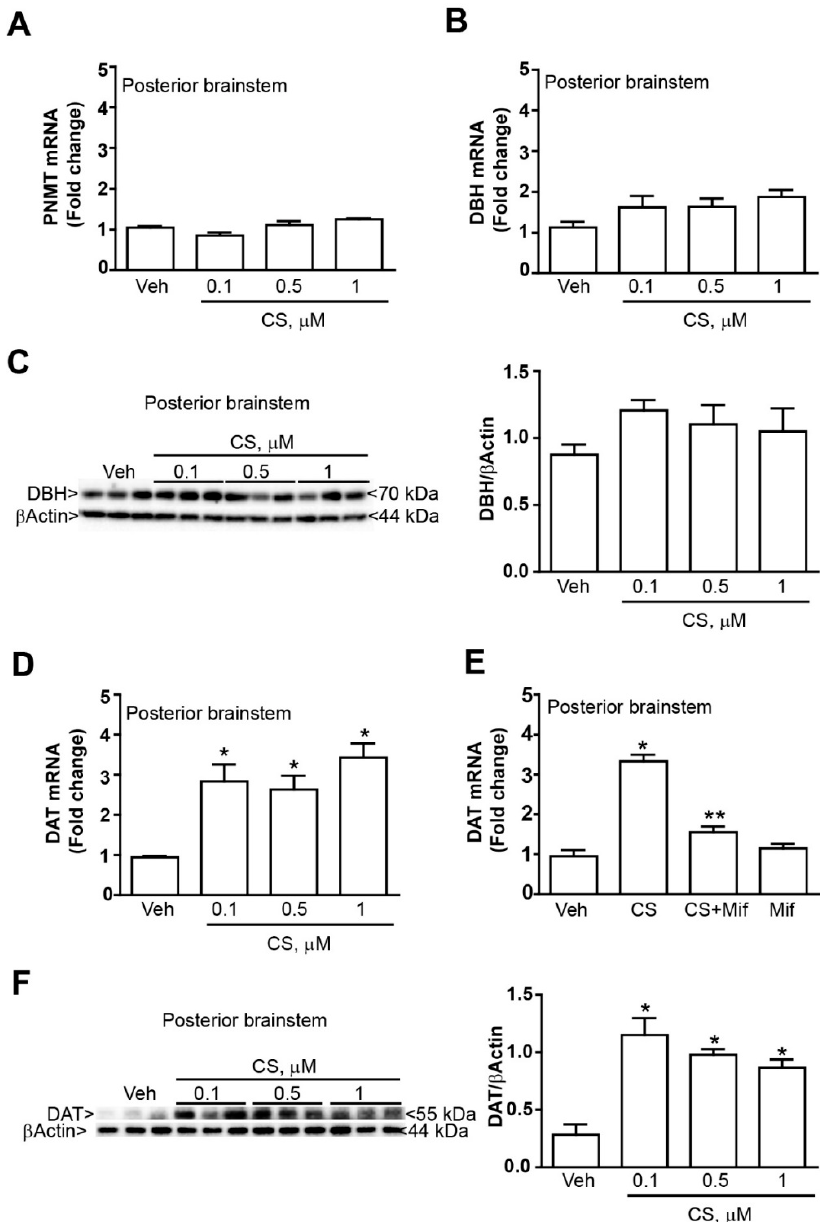
Figure 4. Corticosterone increases DAT expression without modifying DBH and PNMT expression in the mouse brainstem . Real time PCR of ( A ) the adrenergic marker PNMT and ( B ) the noradrenergic marker DBH within the caudal part of the brainstem at 24 h incubation with either vehicle (Veh, ethanol 0.01%) or corticosterone (CS, 0.1, 0.5 or 1 µ M). ( C ) Western blot of DBH within the caudal part of the brainstem at 24 h incubation with either vehicle (Veh, ethanol 0.01%) or corticosterone (CS, 0.1, 0.5 or 1 µ M). ( D ) Real time PCR of the dopaminergic marker (DAT) within the caudal part of the brainstem at 24 h incubation with either vehicle (Veh, ethanol 0.01%) or corticosterone (CS, 0.1, 0.5 or 1 µ M). ( E ) Real time PCR of the DAT within the caudal part of the brainstem at 24 h incubation with either vehicle or CS (0.1 µ M), in the presence or absence of the selective glucocorticoid receptors antagonist mifepristone (Mif, 10 µ M). ( F ) Western blot of DAT within the caudal part of the brainstem at 24 h incubation with either vehicle (Veh, ethanol 0.01%) or corticosterone (CS, 0.1, 0.5 or 1 µ M). The lines of the β Actin are the same showed in the Figure 2E as the western blot for DAT was performed by incubating with the anti-DAT primary antibody the very same membrane used for TH immunoblotting. All values are expressed as the means ± SEM. * p < 0.05 compared with the vehicle. ** p < 0.05 compared with the vehicle and CS.